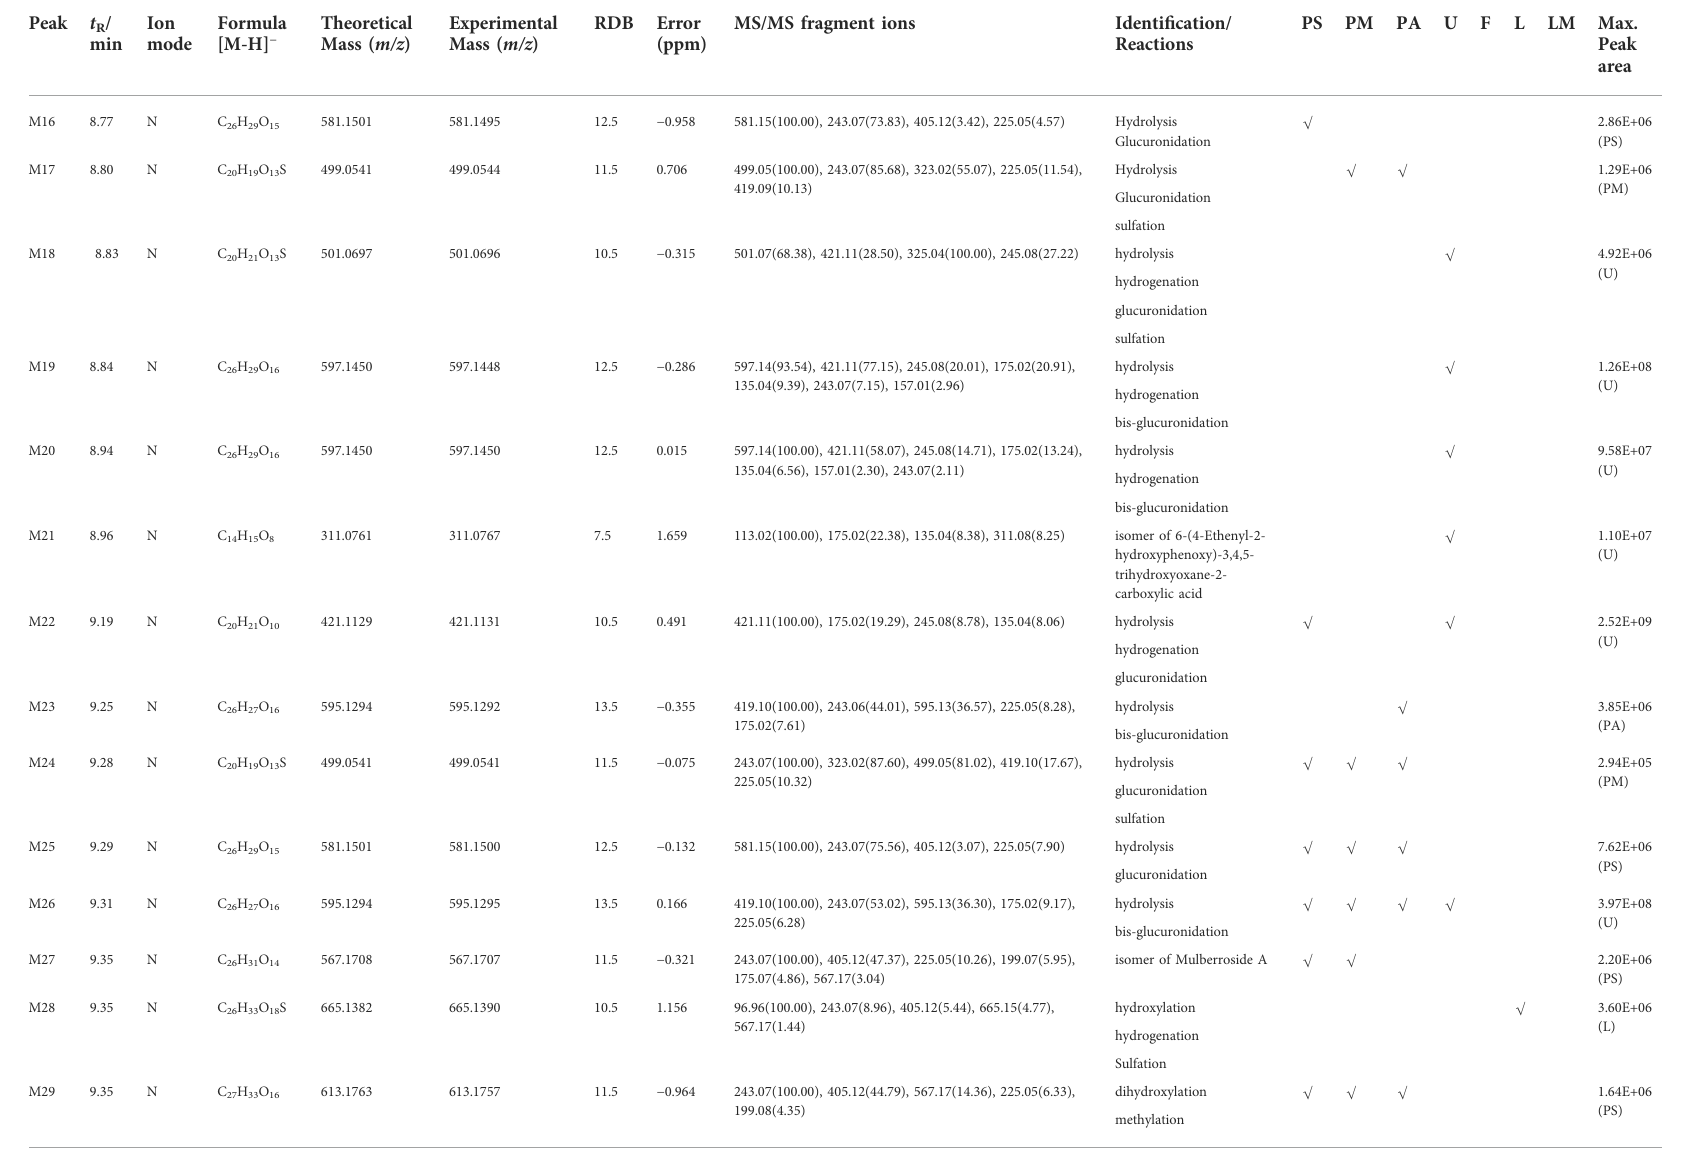
TABLE 1 ( Continued ) Summary of mulberroside A metabolites in vivo and in vitro of